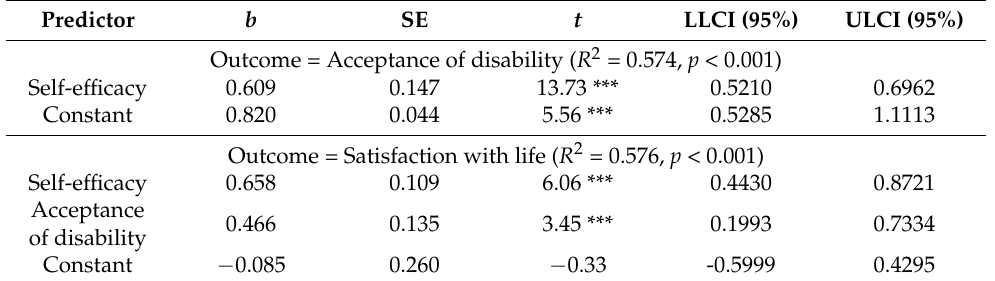
Table 3. Mediation effect of acceptance of disability between self-efficacy and satisfaction with life.